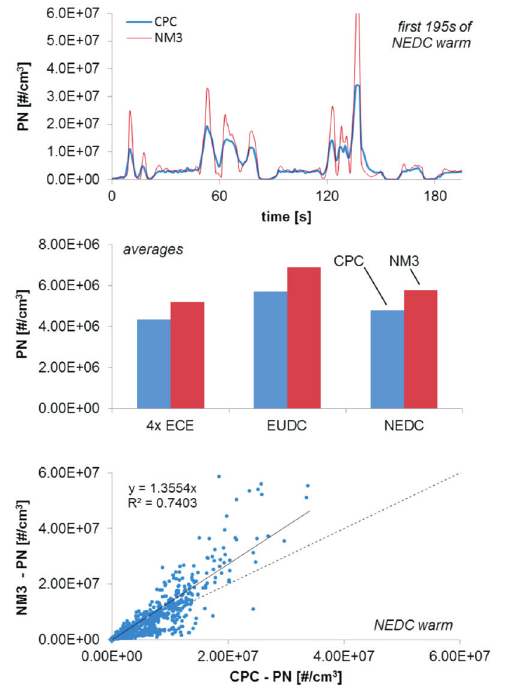
Fig. 11. Particle counts concentrations measured simultaneously at tail - pipe with NanoMet 3 (NM3) and with